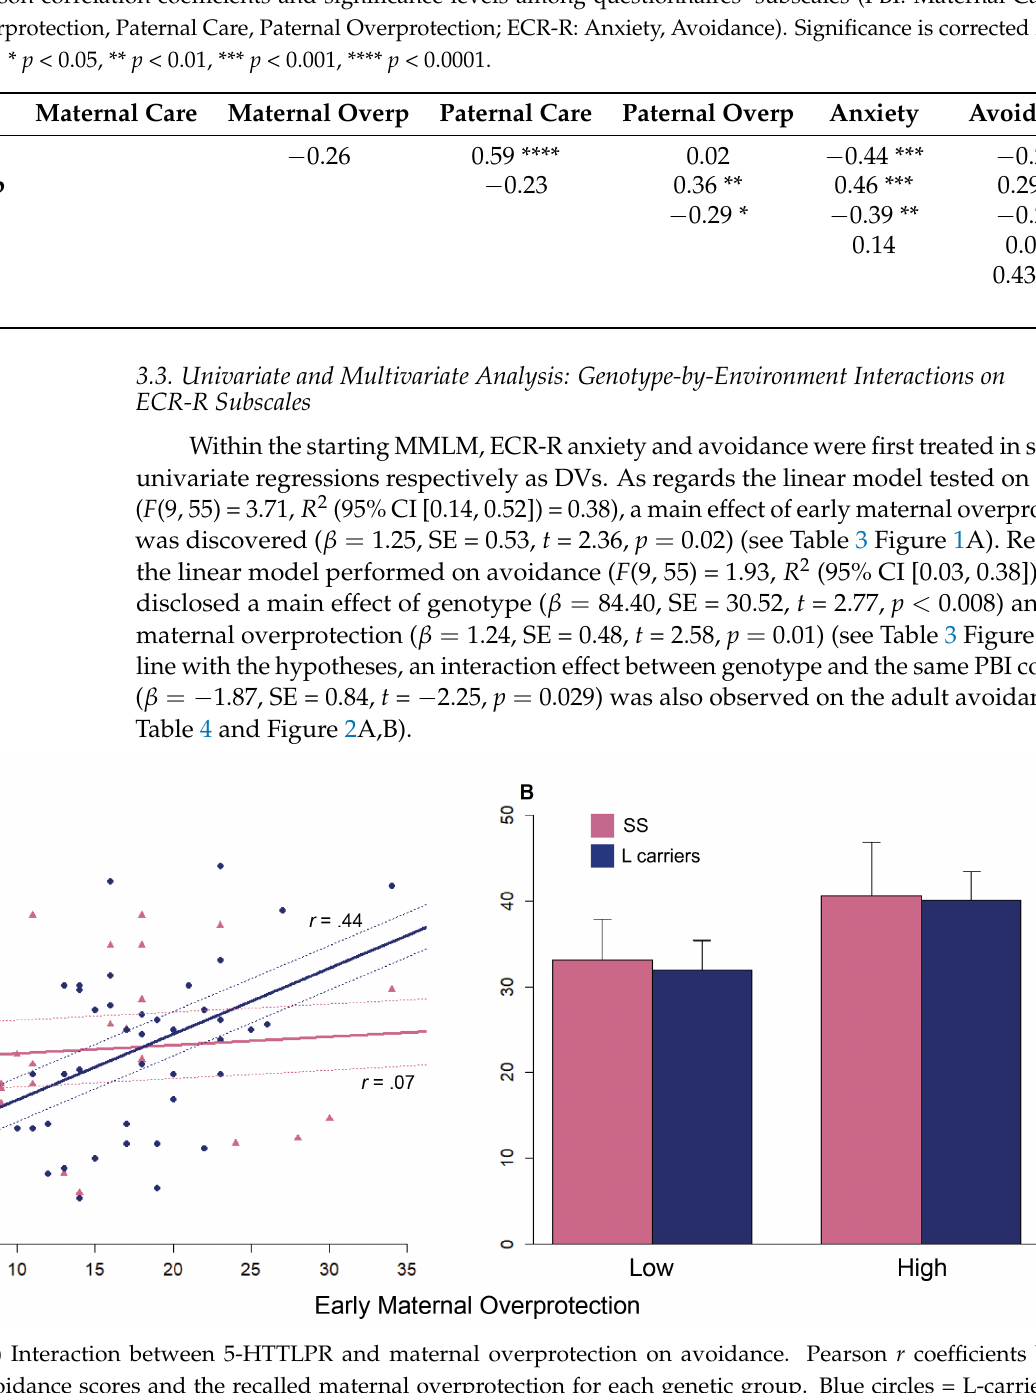
Table 2. Pearson correlation coefficients and significance levels among questionnaires’ subscales (PBI: Maternal Care, Maternal Overprotection, Paternal Care, Paternal Overprotection; ECR-R: Anxiety, Avoidance). Significance is corrected for